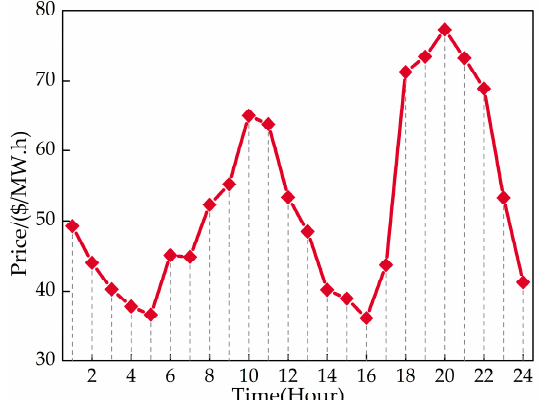
Figure 7. DA market clearing price. Energies 2016 , 9 , x FOR PEER REVIEW